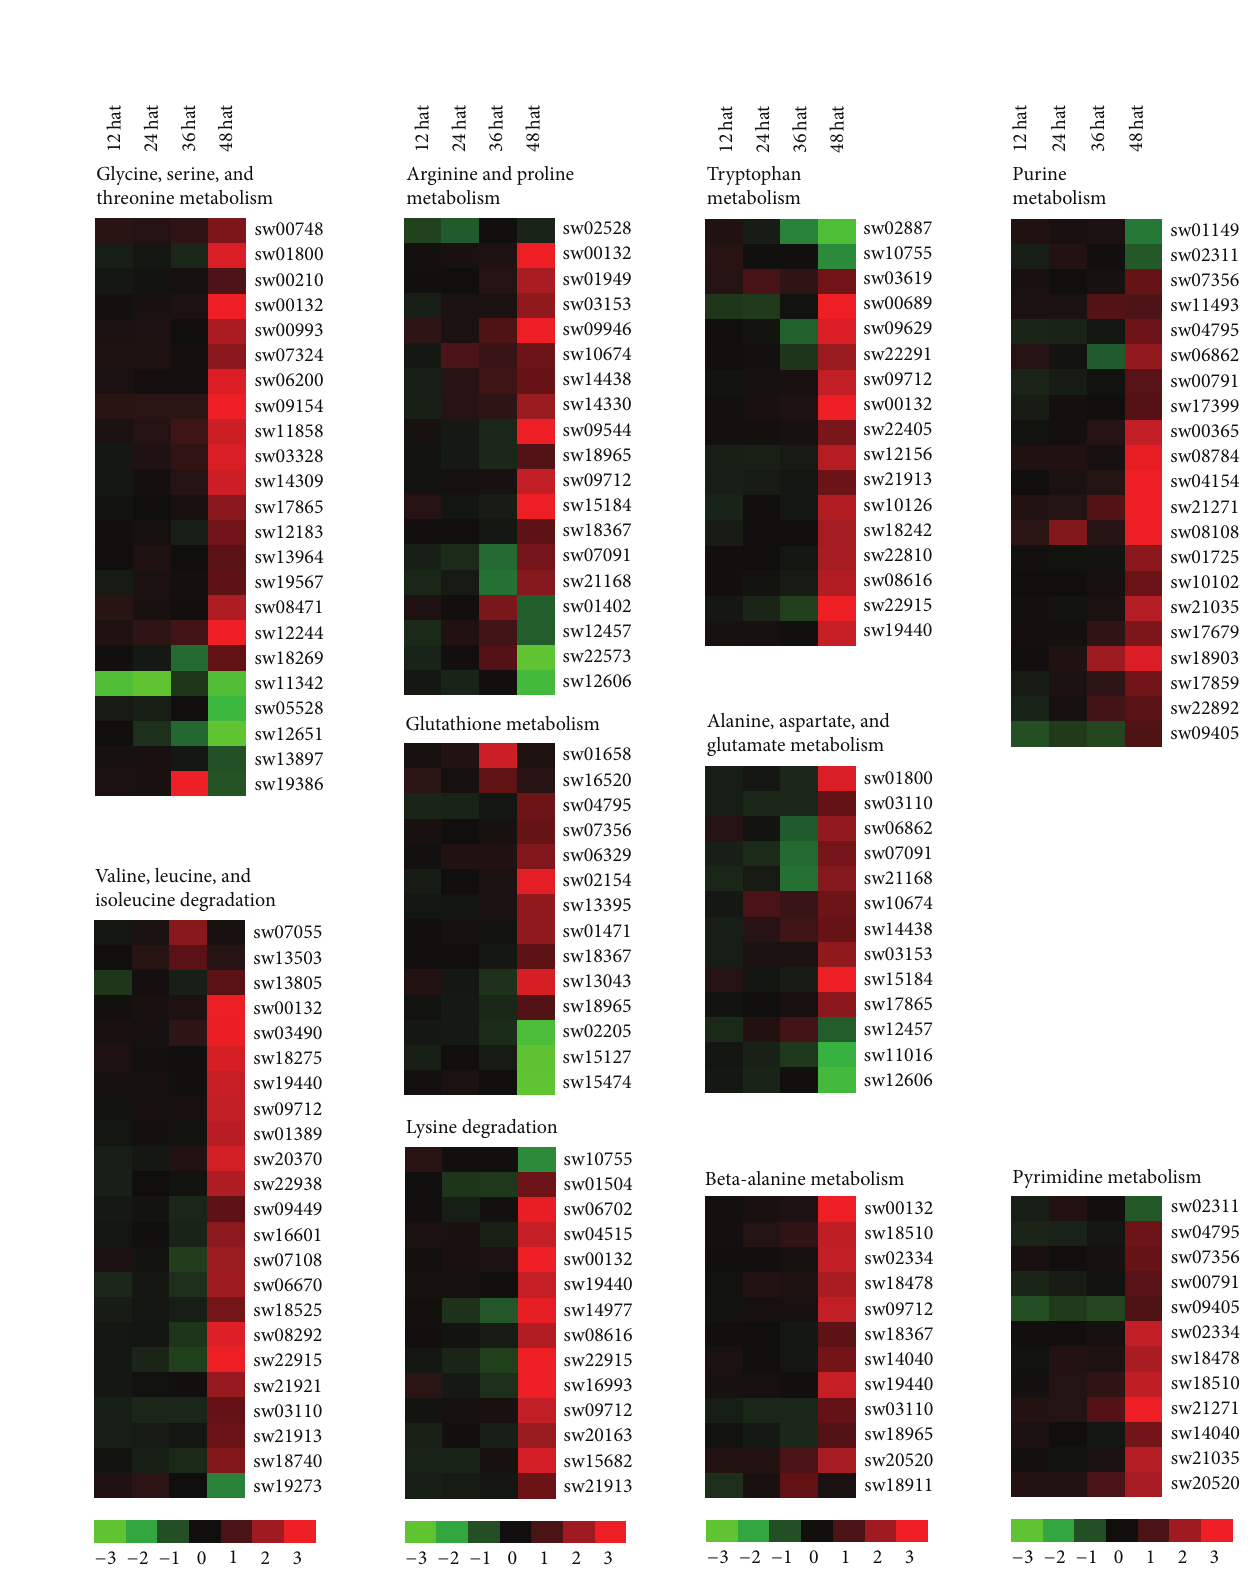
Figure 5: JHA-modulated pathways involved in amino acid and nucleotide metabolisms. Hierarchical clustering of JHA-modulated genes involved in eight pathways related to amino acid metabolism and two pathways related to nucleotide metabolism. The probe ID, KEGG ID, and expression intensity of each JHA-modulated gene are listed in Tables S5 and S8. Hat: hours after